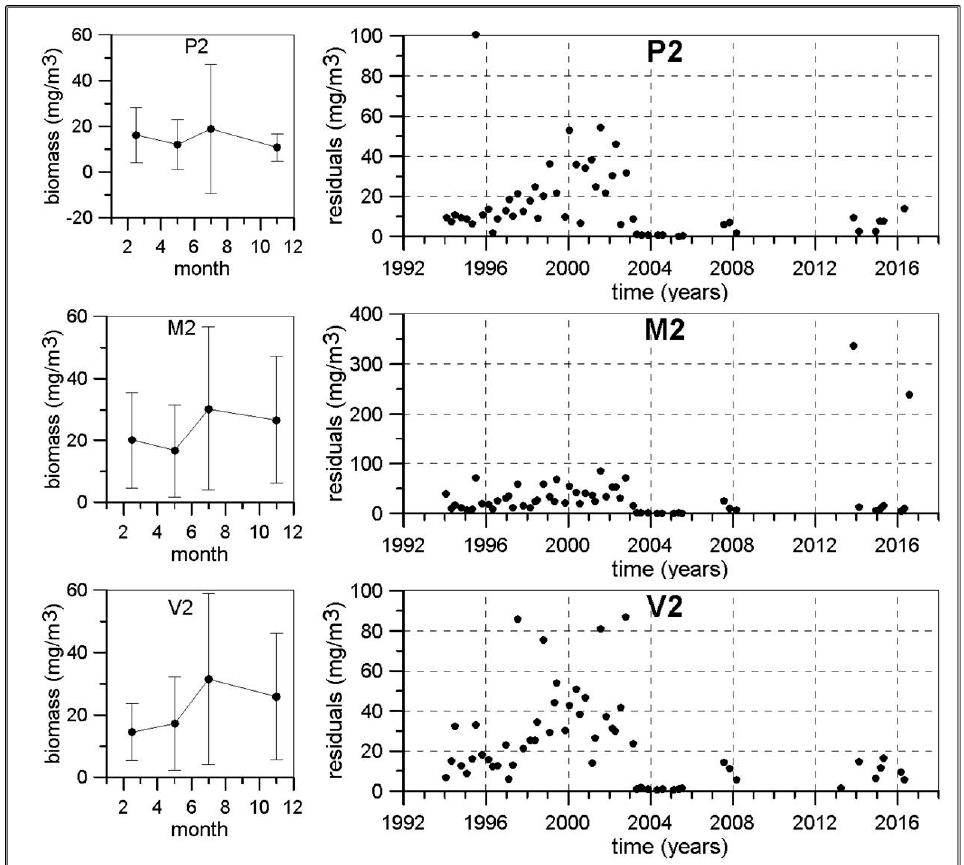
Figure 11. Relative abundances expressed as percentages for broad groups of the meso-zooplankton at the station B1 in Palma transect. This figure has been done using data in Fernandez de Puelles et al. [43].